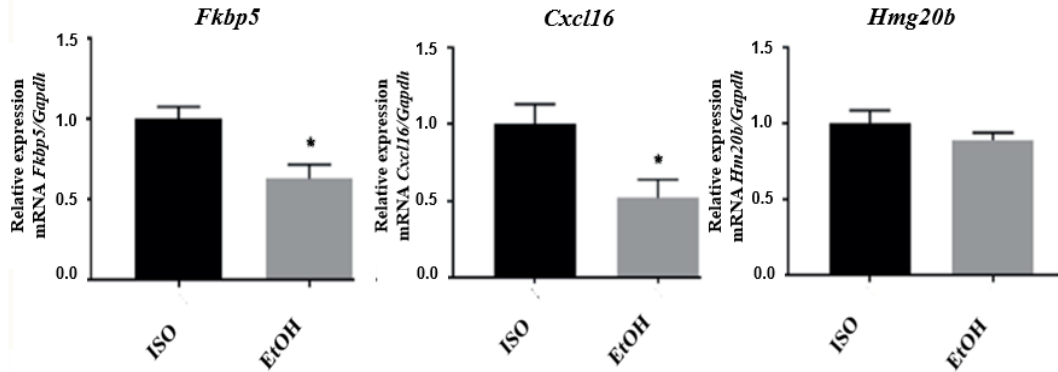
Figure 1. mRNA quantification and relative expression of genes altered by EtOH exposure in the nucleus accumbens. Fold change < 1 indicates reduced expression in response to ethanol relative to a value of 1. * p < 0.05.